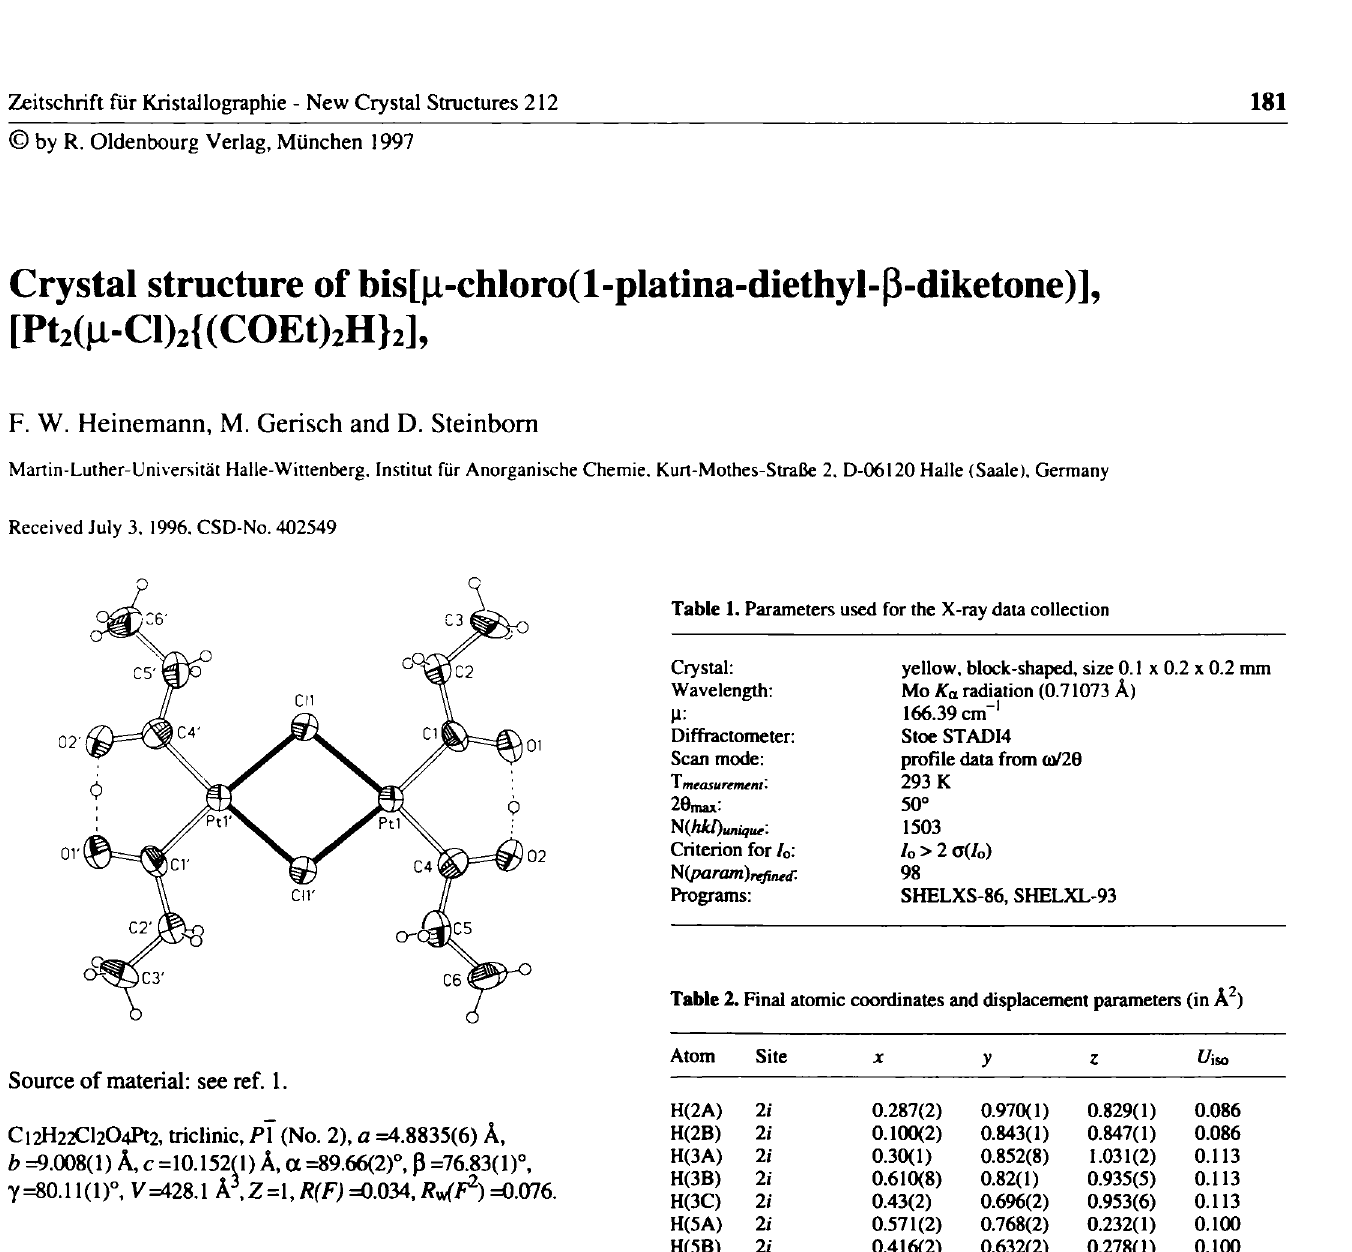
Table 3. Final atomic coordinates and displacement parameters (in Â 2